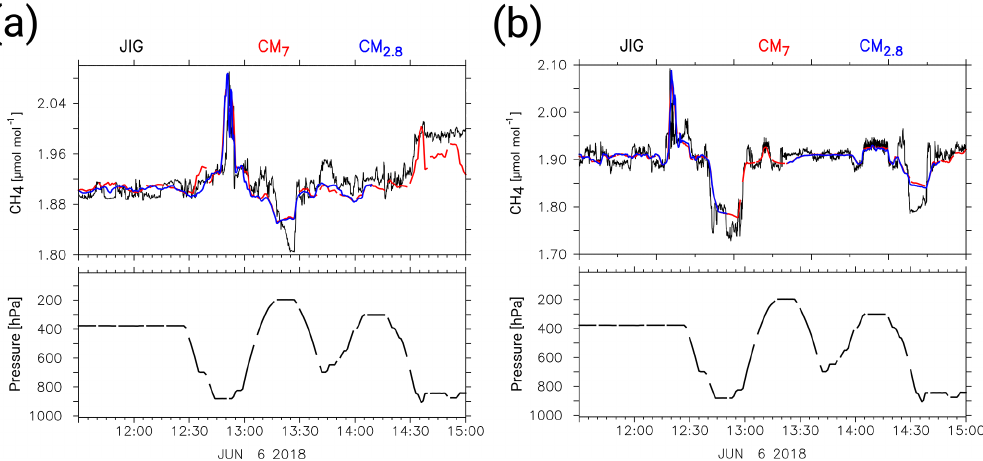
Figure 8. HALO in situ sampled methane mixing ratios (black lines) of J1 (a) and J2 (b) , as well as the S4D submodel output at flight level for CM7 (red dots) and CM2.8 (blue dots). All mixing ratios are in micromoles per mole (µmolmol − 1 ), and the model results are bias-corrected. Below the methane mixing ratios, the atmospheric pressure along the flight track is shown in hectopascals (hPa). The time axis displays the time of the specific flight in